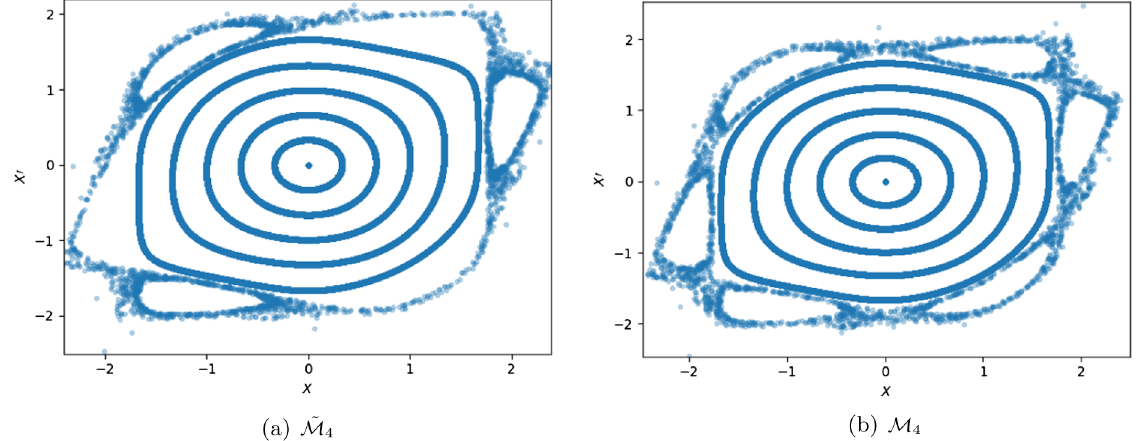
Fig. 14, the integer, Q x ¼ 2 = 3 , Q y ¼ 2 = 3 and the Q x þ Q ¼ 4 = 3 resonances confining the tune footprint. y